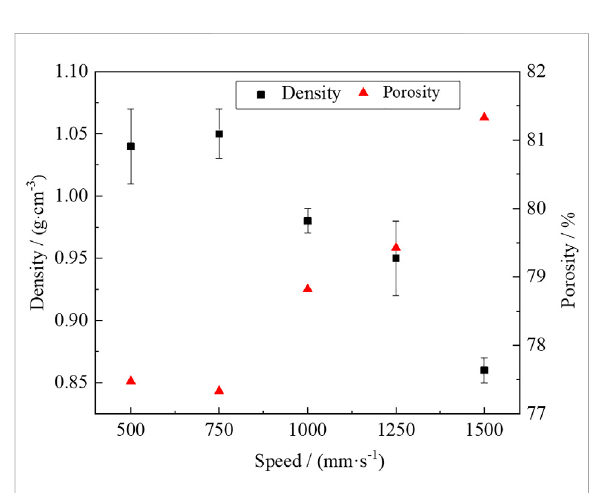
FIGURE 7 Densities and porosity of the SLMed-porous materials as a function of laser scanning